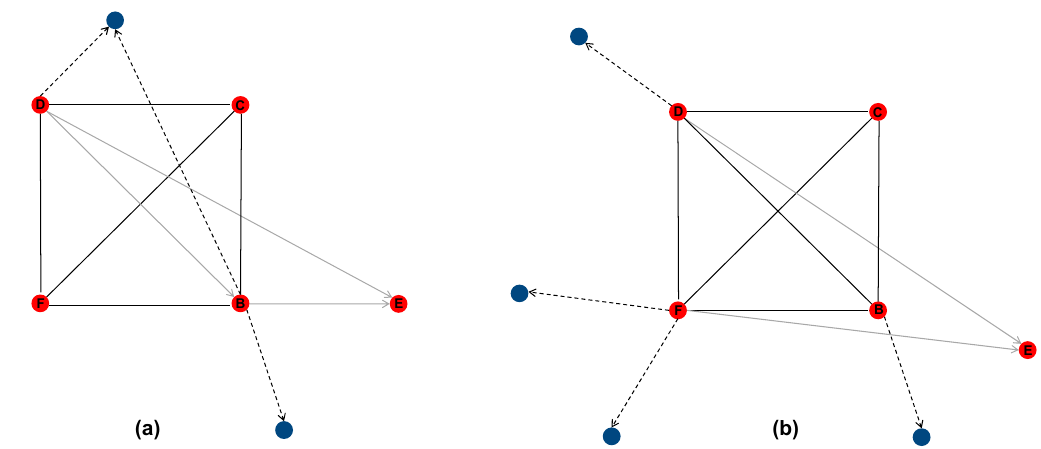
Figure 1. The network of contacts between the interviewed farms and between them and other social farms in the area at T0 ( a ) and T1 ( b ). Circles represent the nodes. The red circles are the egos (the interviewed farms), and the blue circles represent other social farms that were referred to be linked to. Lines represent the links connecting pairs of nodes. The black lines represent links indicated by both actors; the grey arrows represent links indicated only by one of the two actors. When only one of the two actors was interviewed (ties with other social farms in the area), links are represented by dash lines. Second, we analyzed whether the ego networks of the participating farms were connected through sharing of alters. We considered two farms as directly sharing alters when they identify the same node in their ego networks. At T0 (Figure 2a) the survey identified nine shared alters, which represent less than 3% of the total nodes reported by the participating farms. At T1 (Figure 2b), shared alters were 40 (representing 10% of the total at T1). Int. J. Environ. Res. Public Health 2019 , 16 , x